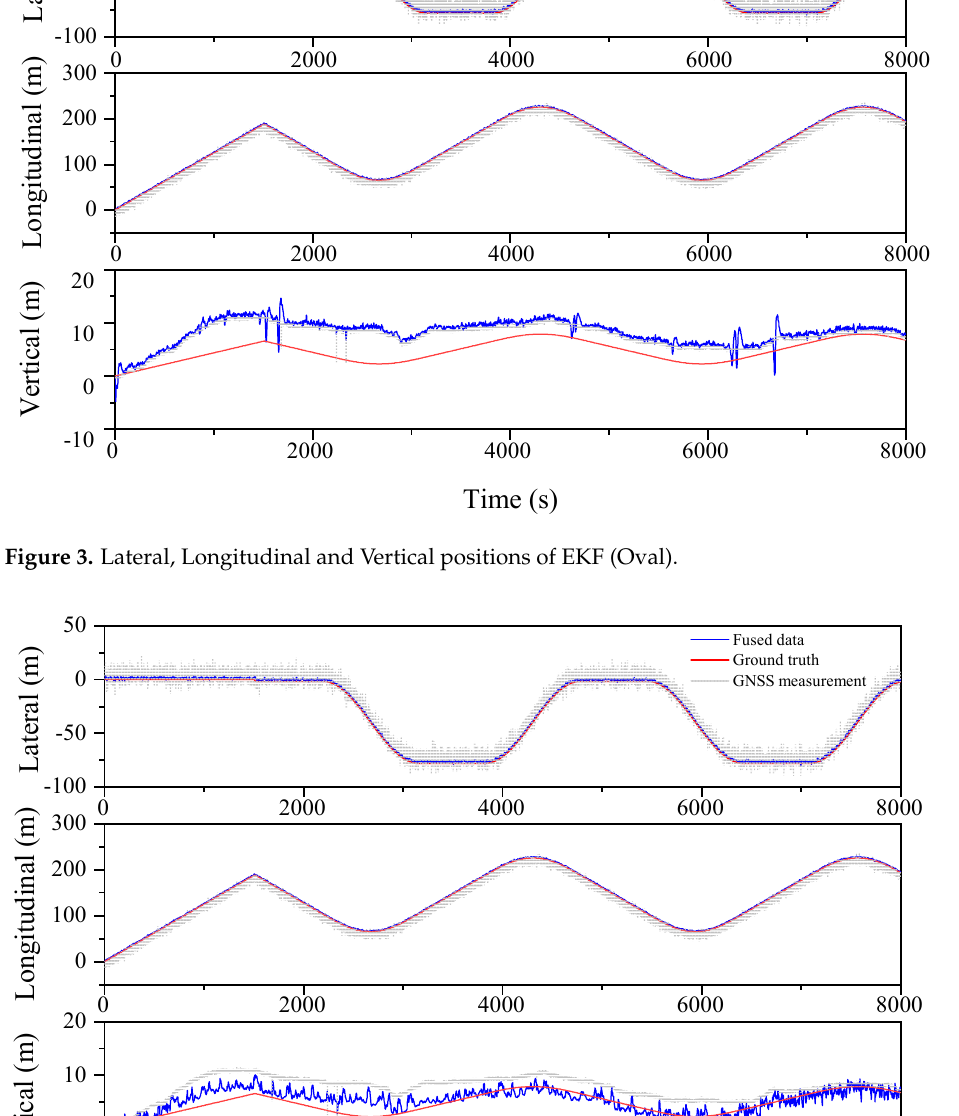
Figure 5. Lateral, Longitudinal and Vertical positions of ESKF–RTS (Oval).